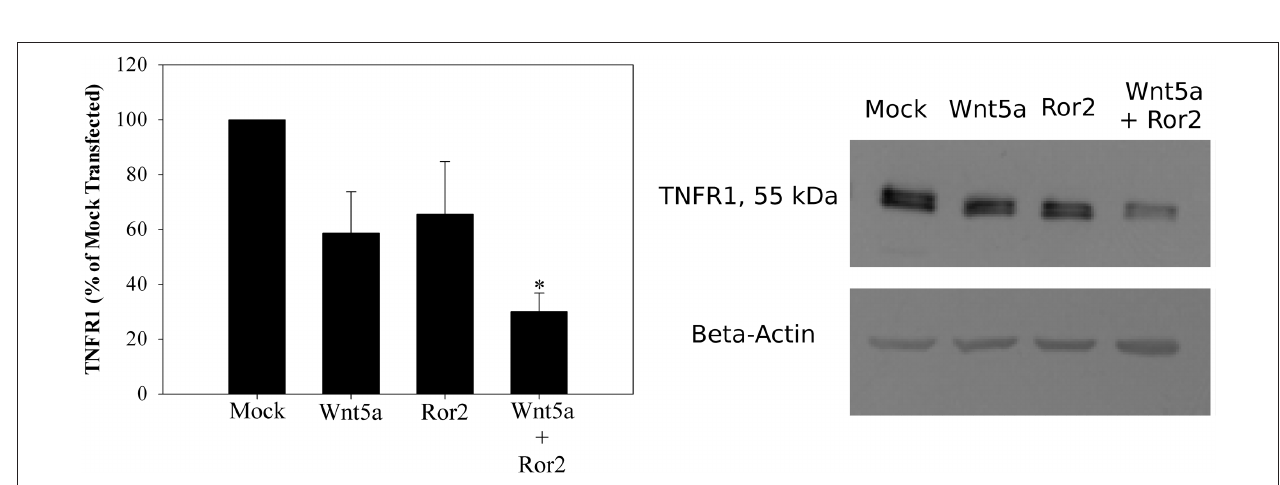
18 h. Lysates were recovered and western blot analysis demonstrated a 70% reduction in TNFR1 protein expression in Wnt5a treated, Ror2 overexpressed HT29 cells. * p < 0.05, n